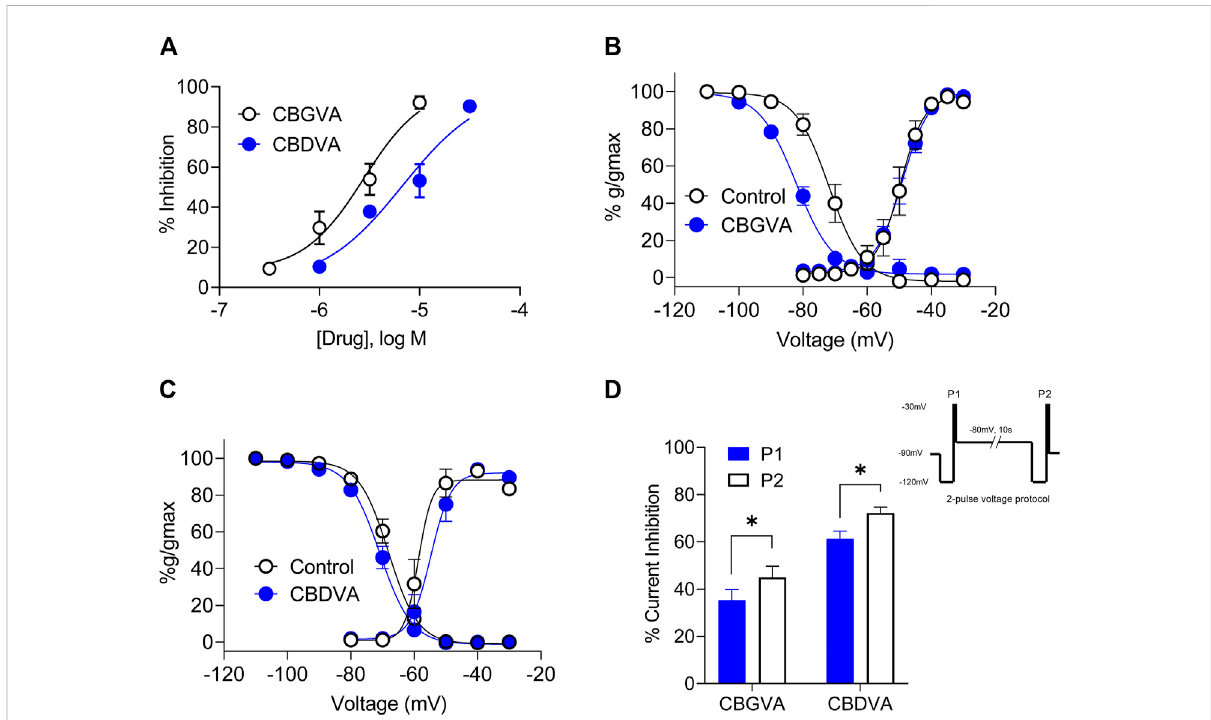
FIGURE 2 CBGVA and CBDVA inhibit Cav3.1 channel currents. (A) Concentration-response curve for CBGVA and CBDVA inhibition of Ca v 3.1 channels. Whole-cellpatch-clamp recordingsweremade fromHEK T-rex Ca v 3.1channel currents evoked by stepping − 100 mv to − 30mv every 12 s.Steady- state activation and inactivation curves of HEK Ca v 3.1 in the absence (control) and presence of (B) CBGVA (5 µM) (C) CBDVA (5 µM). Data presented are mean ± SEM of 10 – 11 cells. (D) Ca v 3.1 channel slow inactivated state was elicited by a 2-pulse voltage protocol (inset). This elicited a signi fi cant increase in peak current inhibition by CBGVA and CBDVA. Data presented are mean ± SEM of % inhibition of peak current of vehicle control for 9 cells. Statistical analysis was performed using a student T-test with * denoting p < 0.05. Some data points do not have visible error bars due to low